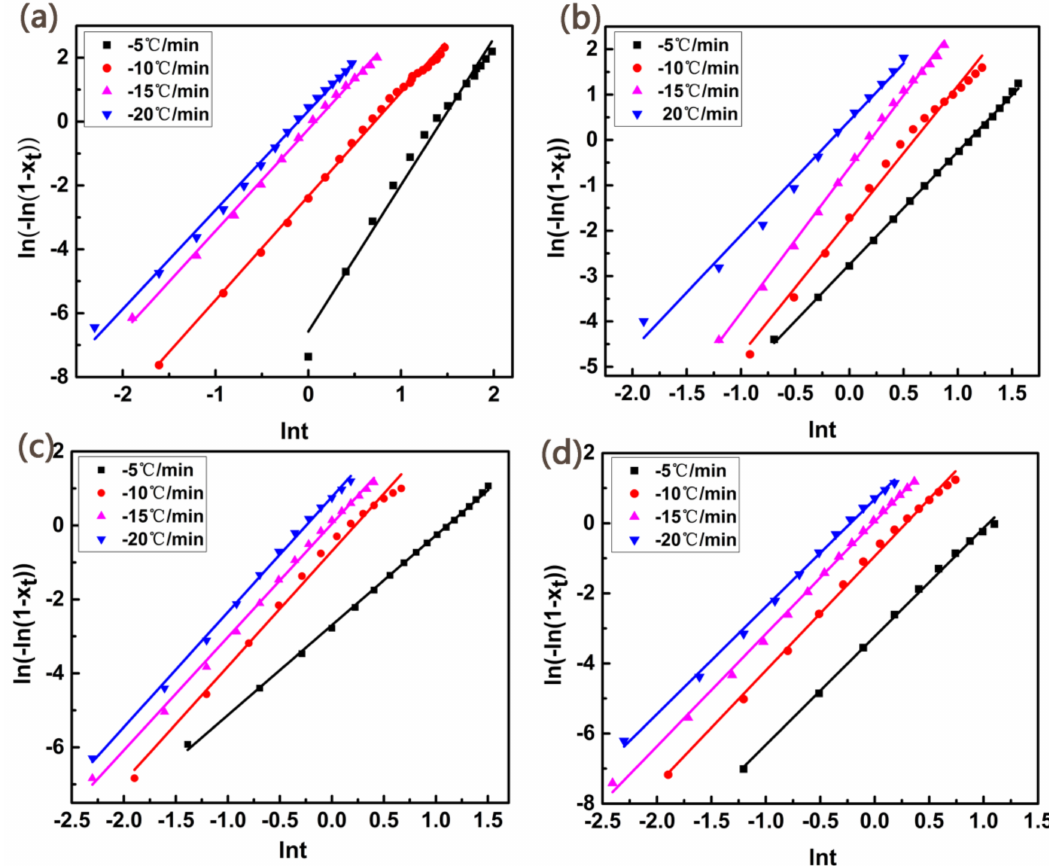
Figure 10. Plots of ln[ − ln(1 − X t )] vs. lnt for ( a ) PET; ( b ) PET/PET-3; ( c ) PET/PET-4 and ( d ) PET/PET-5 at different cooling